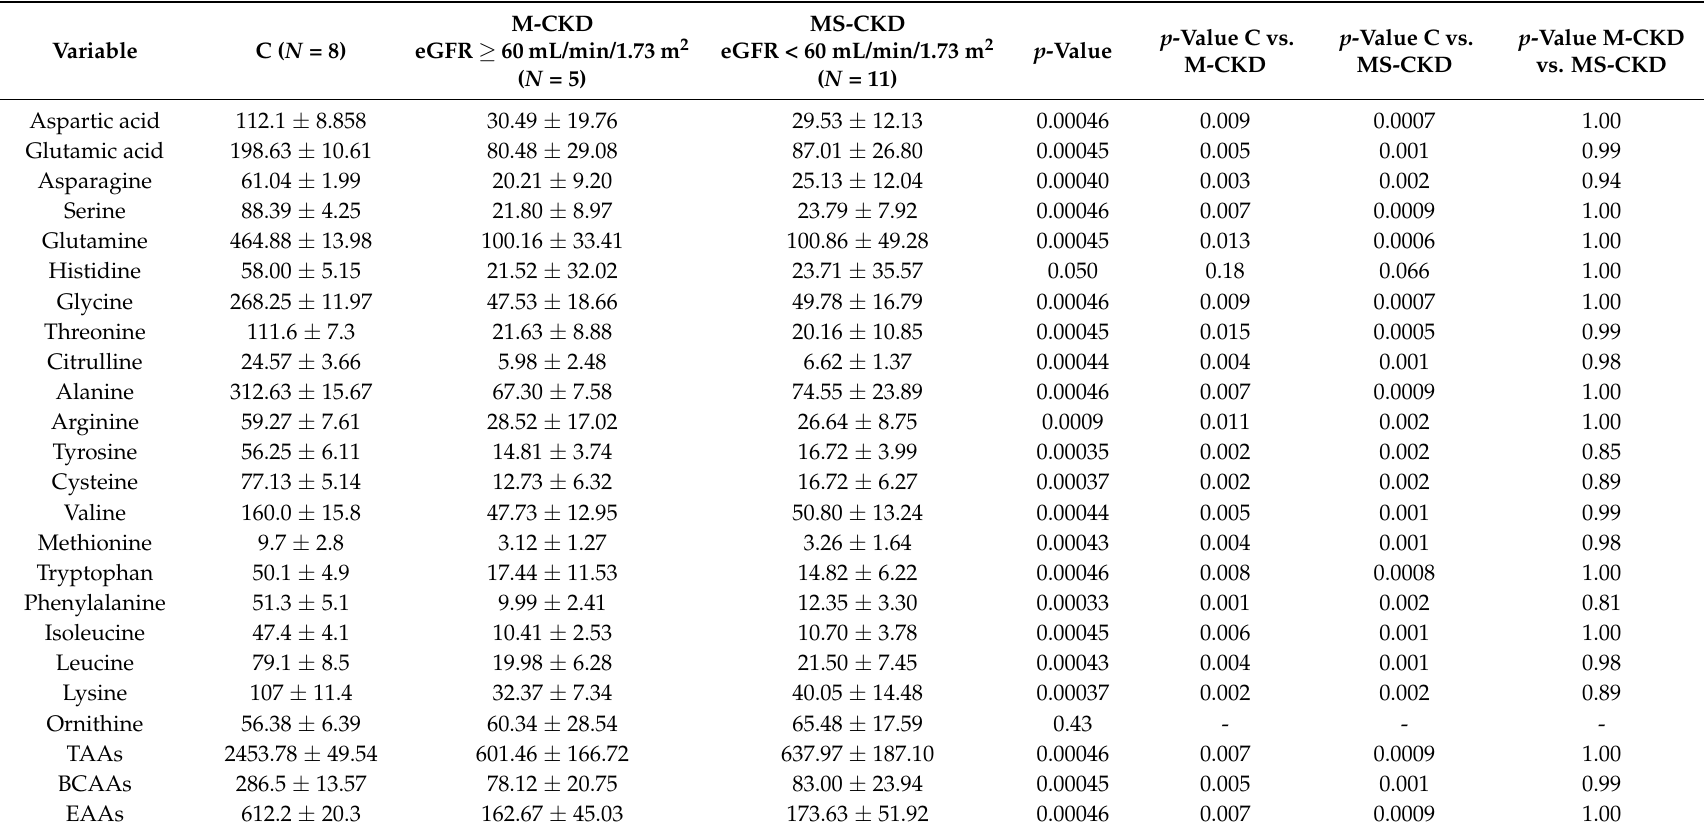
Table 6. Plasma arterial AA concentrations ( µ mol/L) in controls (C) and cardiorenal syndrome type 2 (CRS 2) patients after stratification for eGFR ≥ 60 mL/min/1.73 m 2 (mild CKD: M-CKD) and eGFR < 60 mL/min/1.73 m 2 (moderate-severe CKD: